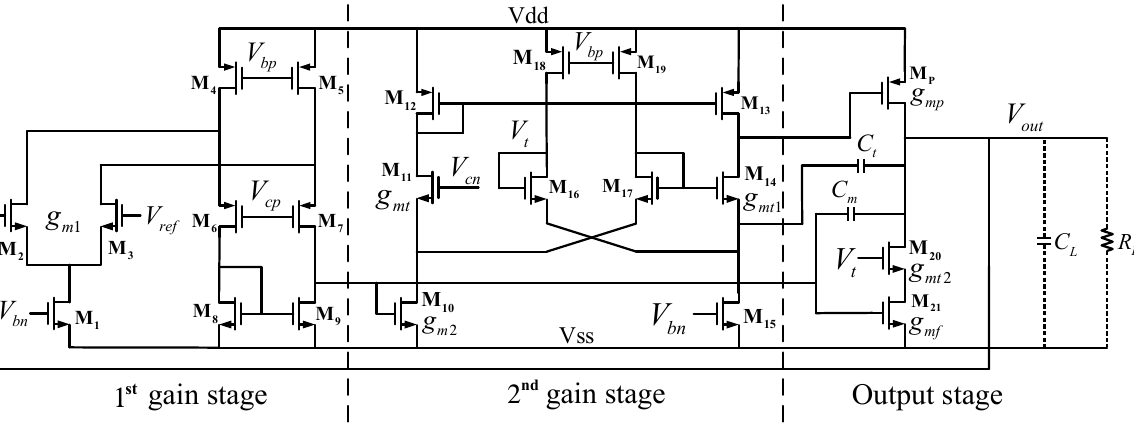
Figure 5. Full schematic of the proposed OCL − LDO regulator.